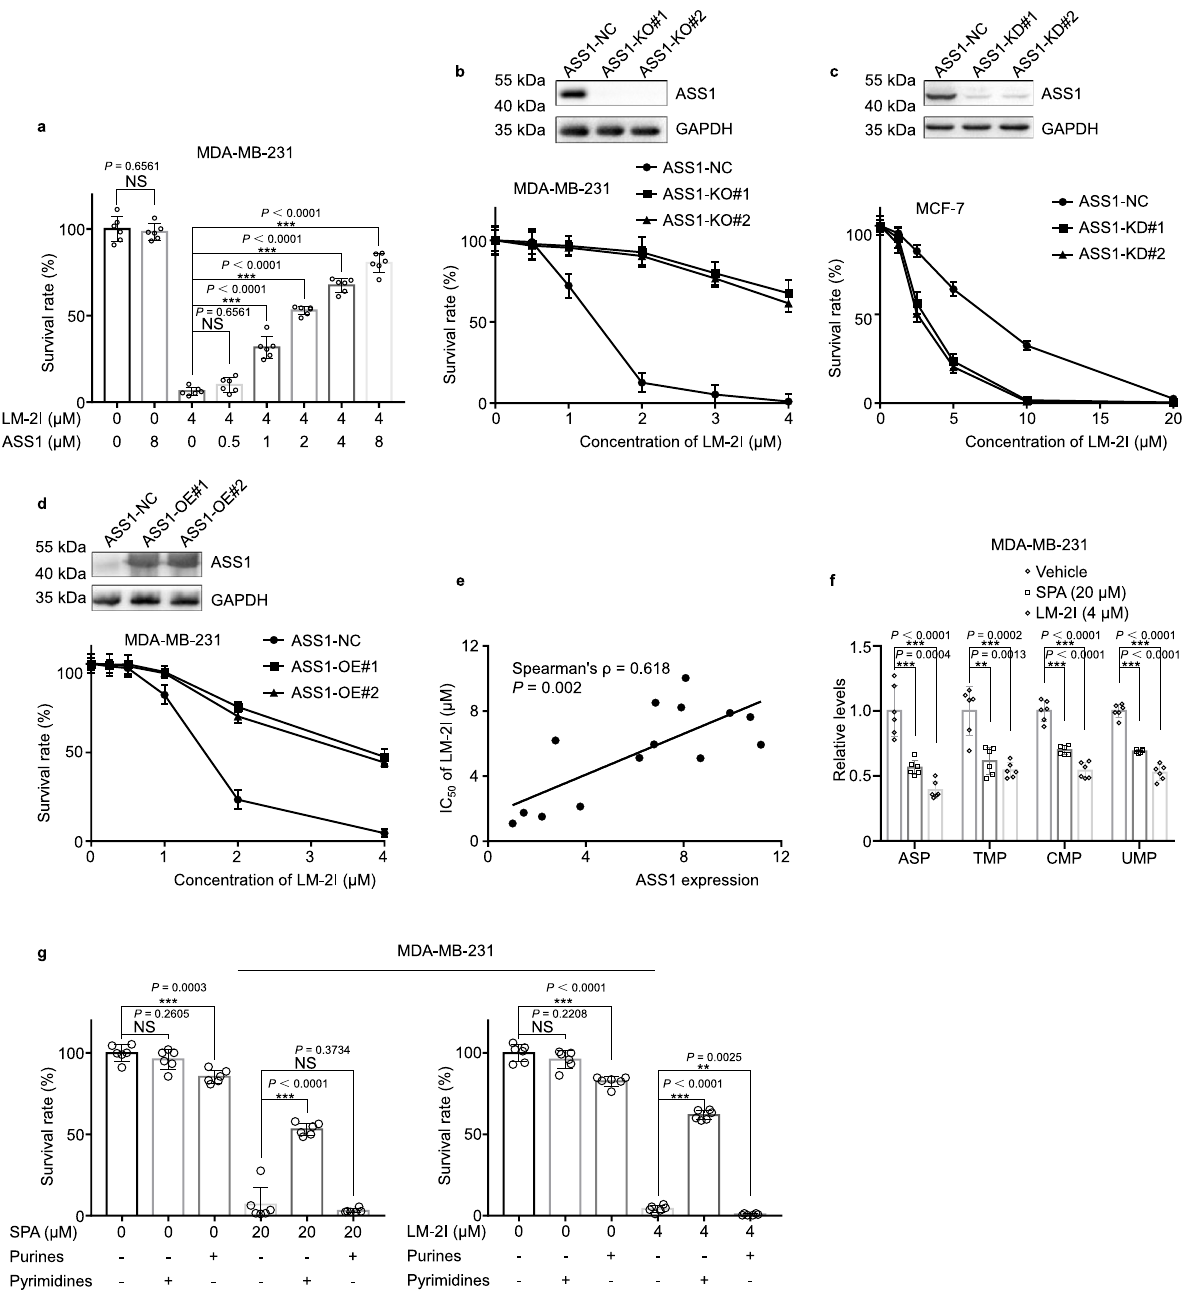
Fig. 6 ASS1 is indeed the target of SPA and LM-2I. a Crystal violet assay for the viability of MDA-MB-231 cells treated with LM-2I or LM-2I pre-incubated with different concentrations of ASS1 recombinant protein (mean ± s.d., n = 6 biologically independent experiments). *** P < 0.001, NS: not signi fi cant ( P > 0.05) from two-tailed unpaired Student ’ s t -tests. b Western blot for ASS1 expression in control or stable ASS1 knockout (ASS1-KO) MDA-MB-231 cells (top). Crystal violet assay for the viability of control and ASS1-KO MDA-MB-231 cells treated with LM-2I (bottom) (mean ± s.d., n = 3 biologically independent experiments). c Western blot for ASS1 expression in control or stable ASS1 knockdown (ASS1-KD) MCF-7 cells (top). Crystal violet assay for the viability of control and ASS1-KD MCF-7 cells treated with LM-2I (bottom) (mean ± s.d., n = 3 biologically independent experiments). d Western blot for ASS1 expression in control or stable ASS1 overexpression (ASS1-OE) MDA-MB-231 cells (top). Crystal violet assay for the viability of control and ASS1-OE MDA-MB-231 cells treated with LM-2I (bottom) (mean ± s.d., n = 3 biologically independent experiments). e The correlation between the relative ASS1 expression in cells and the IC 50 of these cells treated with LM-2I ( n = 3 independent experiments from n = 14 cell lines). P values of mean ± s.d. were determined by Pearson Coef fi cient. f LC-MS analysis of ASP, UMP, CMP, and TMP in MDA-MB-231 cells treated with SPA, LM-2I or vehicles for 24 h (mean ± s.d., n = 6 biologically independent experiments). ** P < 0.01, *** P < 0.001 from two-tailed unpaired Student ’ s t -tests. g Crystal violet assay for the viability of MDA-MB-231 cells preincubated with pyrimidines or purines, followed by treatment with SPA or LM-2I (mean ± s.d., n = 6 biologically independent experiments). ** P < 0.01, *** P < 0.001, NS: not signi fi cant ( P > 0.05) from two-tailed unpaired Student ’ s t -tests.Source data are provided as a Source Data fi